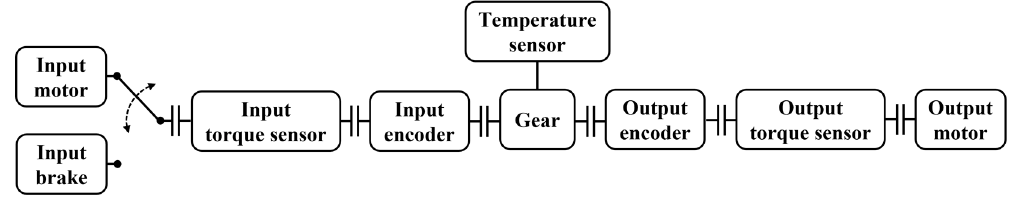
Figure 3. Schematic representation of the test bench used for testing strain wave gears.